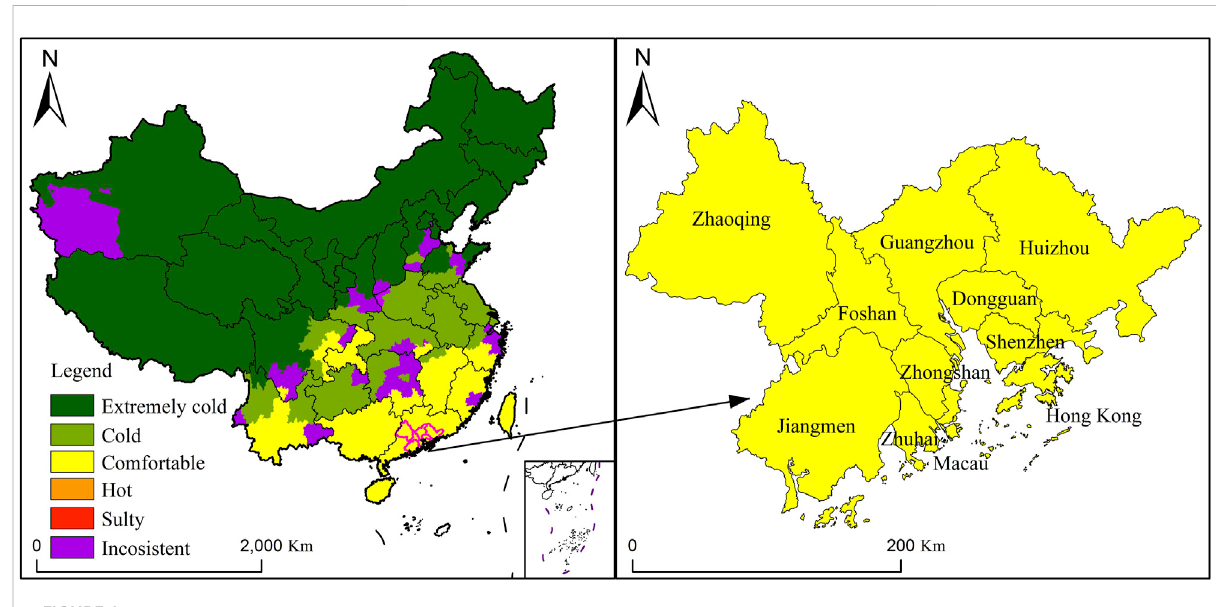
FIGURE 1 The average annual residential climate comfort chart in China from 2005 to 2020 (Map Content Approval Number: GS (2019)1822).